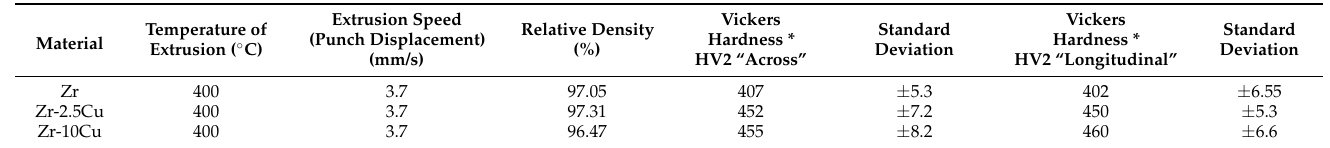
Table 3. Influence of the extrusion process parameters on the relative densities and hardness values of Zr, Zr2.5Cu and Zr10Cu.